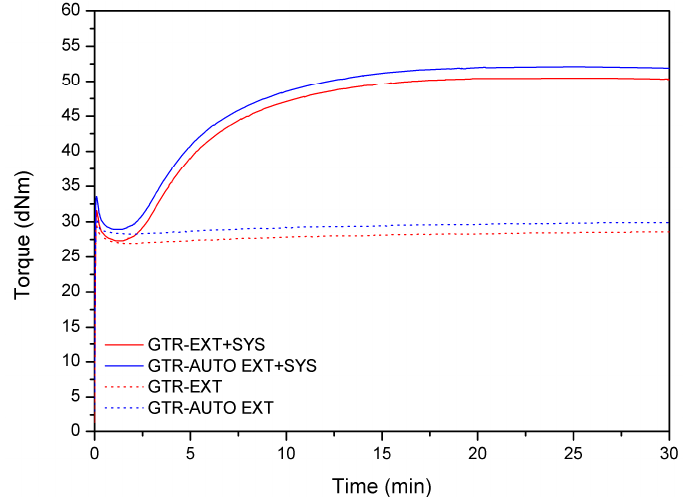
Figure 8. Curing curves for GTR-EXT and GTR-AUTO-EXT samples without and with a curing system (+SYS).